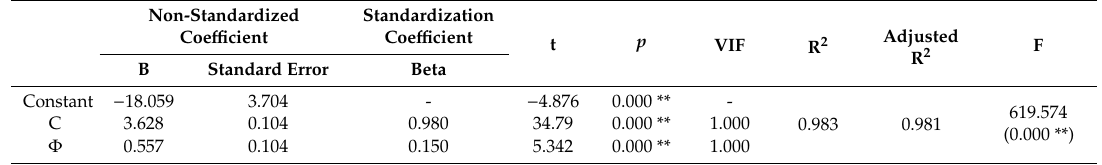
Table 8. Related interpretation parameter sets of stepwise regression